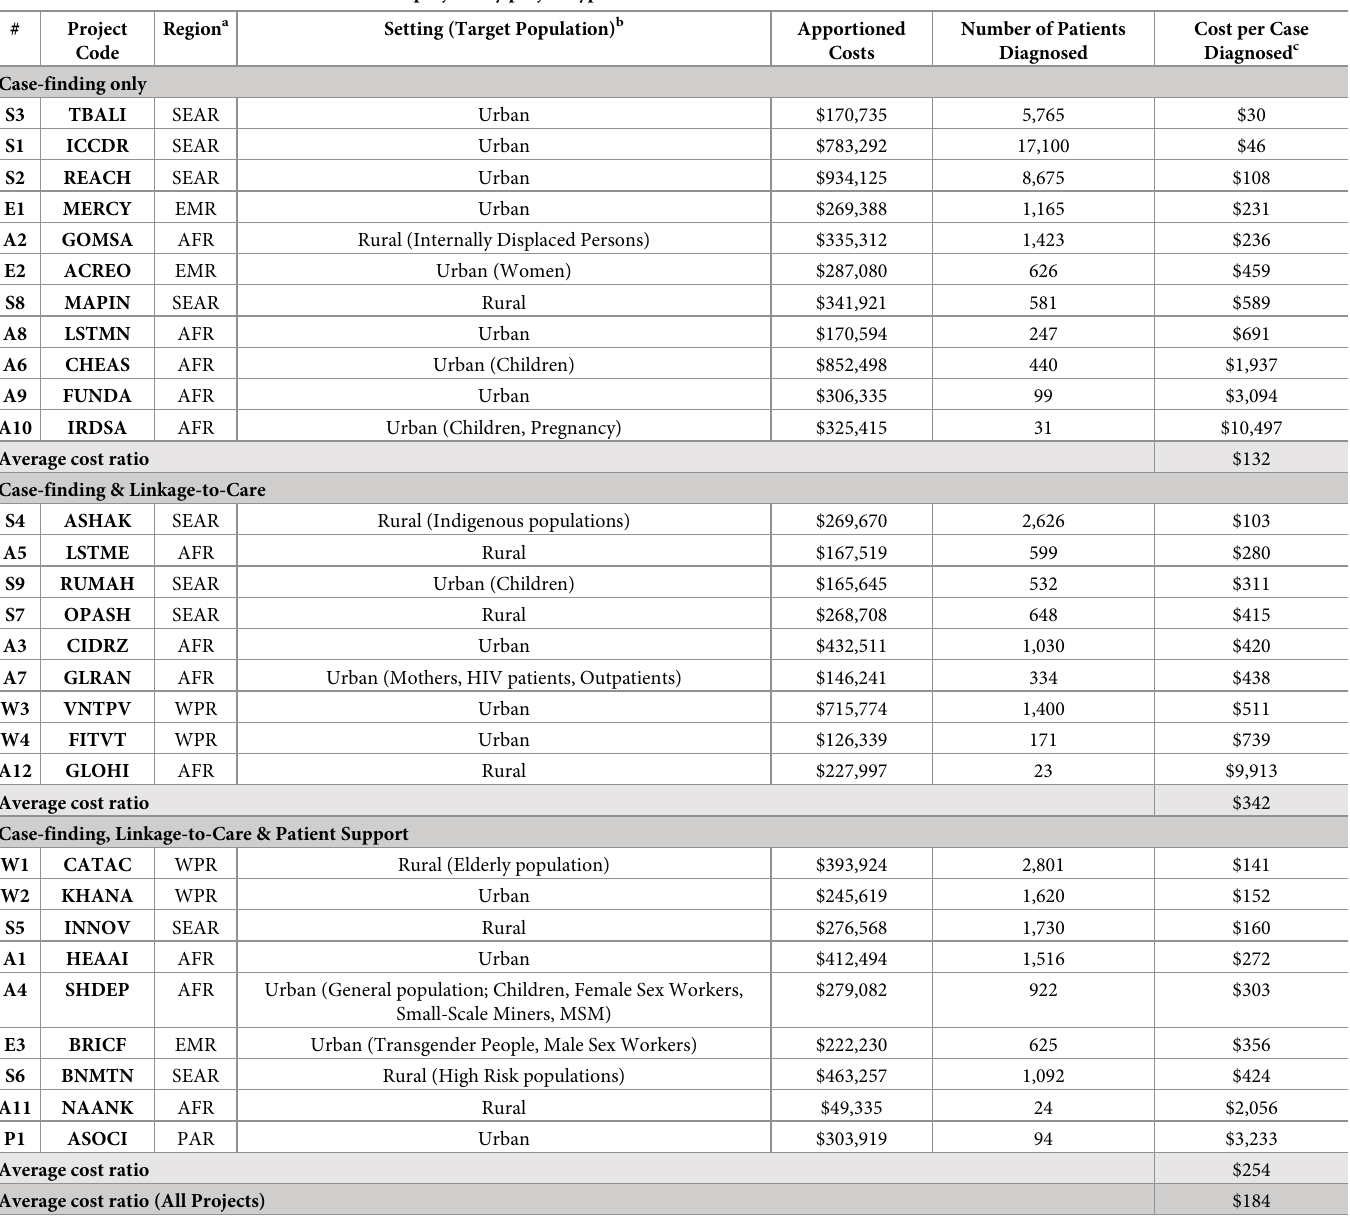
Table 3. Cost-effectiveness of TB REACH Wave 5 projects by project